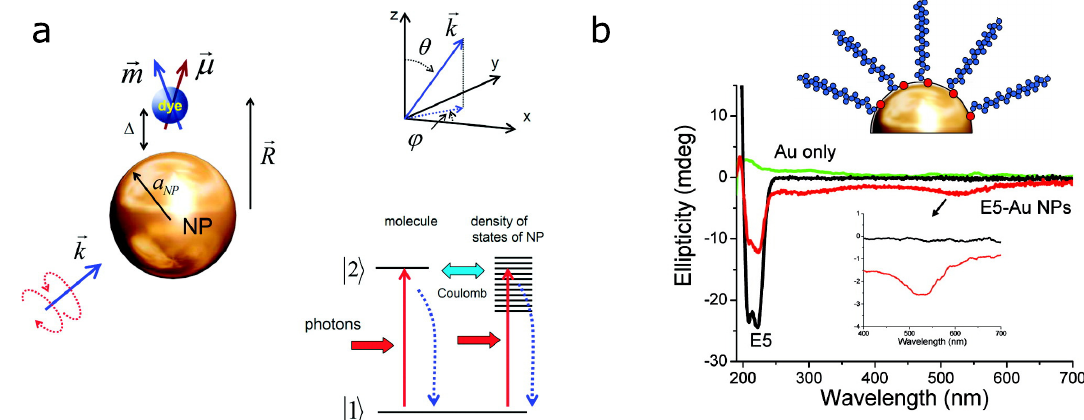
Figure 1. Circular dichroism of coupled molecular-plasmonic systems: ( a ) Schematics of the metal nanoparticle–dye molecule assembly used for theoretical calculations (left) and schematics of quantum transitions (right) with solid vertical (horizontal) arrows representing light (Coulomb)-induced transitions. The dotted vertical arrows are the relaxation processes. Reproduced with permission from Govorov et al. [15] Copyright 2010 American Chemical Society. ( b ) Illustration of gold nanoparticle surface covalently linked to the E5 peptide via the thiol linkage (red circles) and the CD spectra of E5 peptide (black line), gold nanoparticles (green line) and their assembly (red line). Reproduced with permission from Slocik et al. [19] Copyright 2011 American Chemical